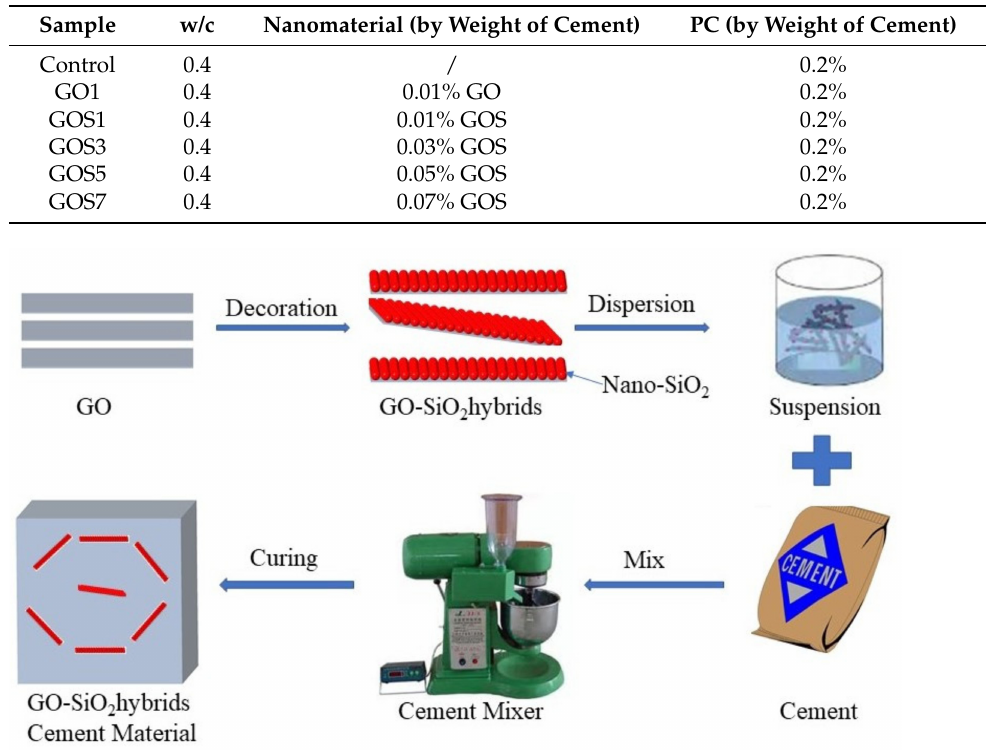
Table 2. Mix design for cement paste.